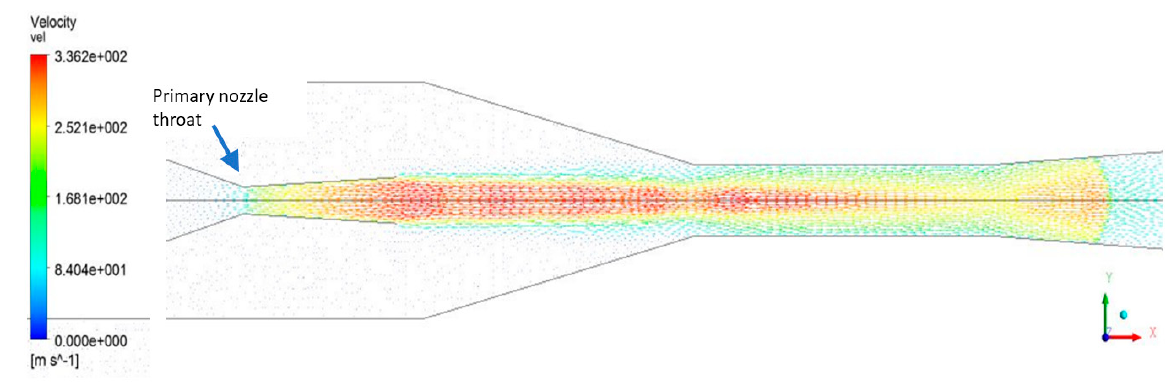
Figure 7. CFD results for R141b working fluid .